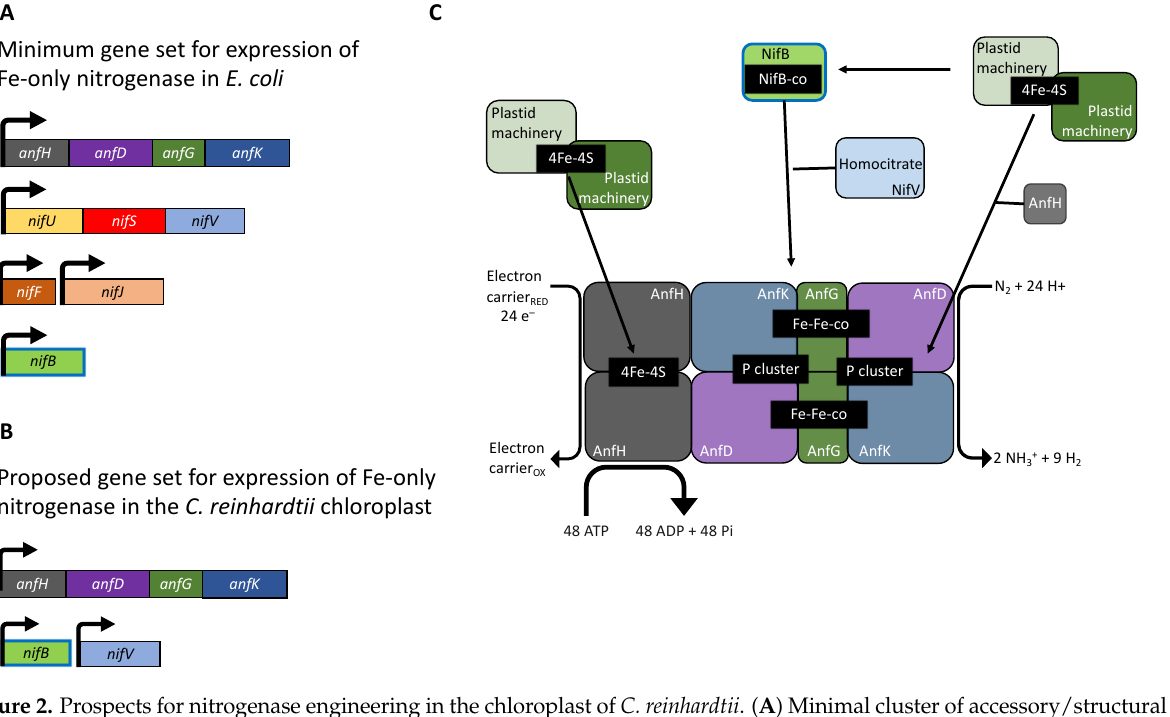
Figure 2. Prospects for nitrogenase engineering in the chloroplast of C. reinhardtii . ( A ) Minimal cluster of accessory/structural genes required for nitrogenase activity in E. coli [15]. ( B ) Suggested minimal set of genes required for a chloroplast nitrogenase. ( C ) Schematic representation of the hypothetic iron-only nitrogenase. The endogenous chloroplast system for assembling Fe-S clusters could provide the catalytic cofactors for cluster assembly. The (SAM)-dependent NifB is required for the fusion of two [4Fe-4S], the addition of a carbon atom, and an additional sulphur to produce the NifB-co [8Fe-9S-C], while NifV provides the homocitrate molecule. The Fe-only nitrogenase is less efficient than its Mo counterpart as it requires as many as 48 ATP molecules and 24 low-potential electrons to reduce one N 2 molecule